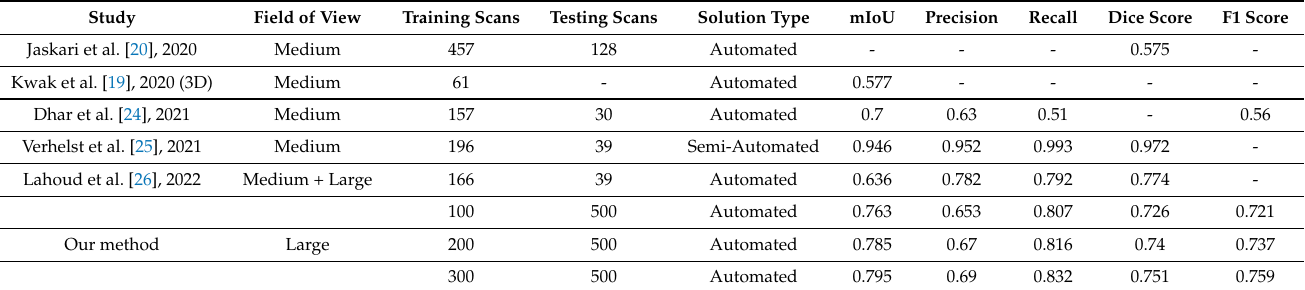
Table 5. Comparison of our technique with other techniques on private dataset.